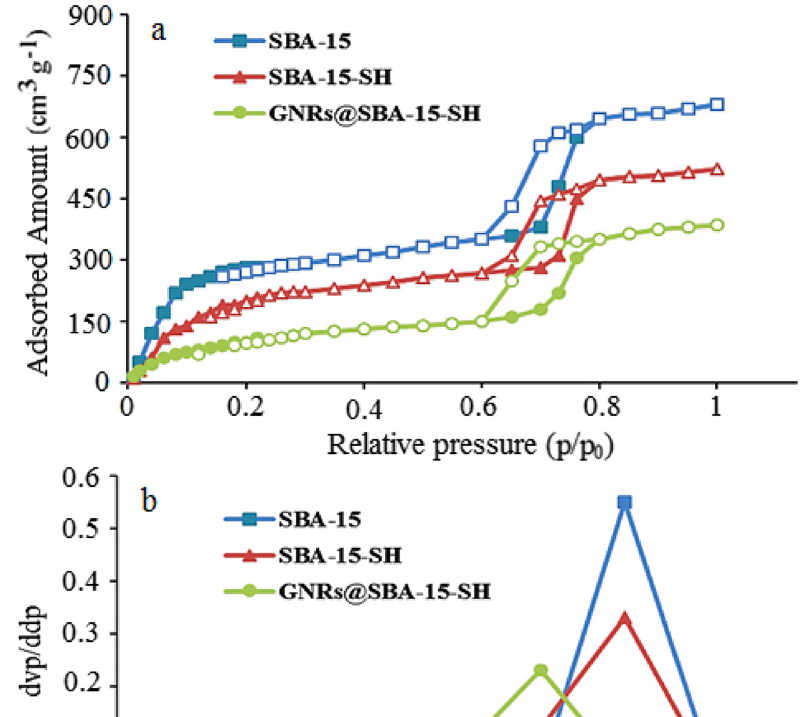
Figure 5: The UV – Vis absorption spectra of GNRs, GNRs@SBA-15-SH and GNRs@SBA- 15-SH/DOX.